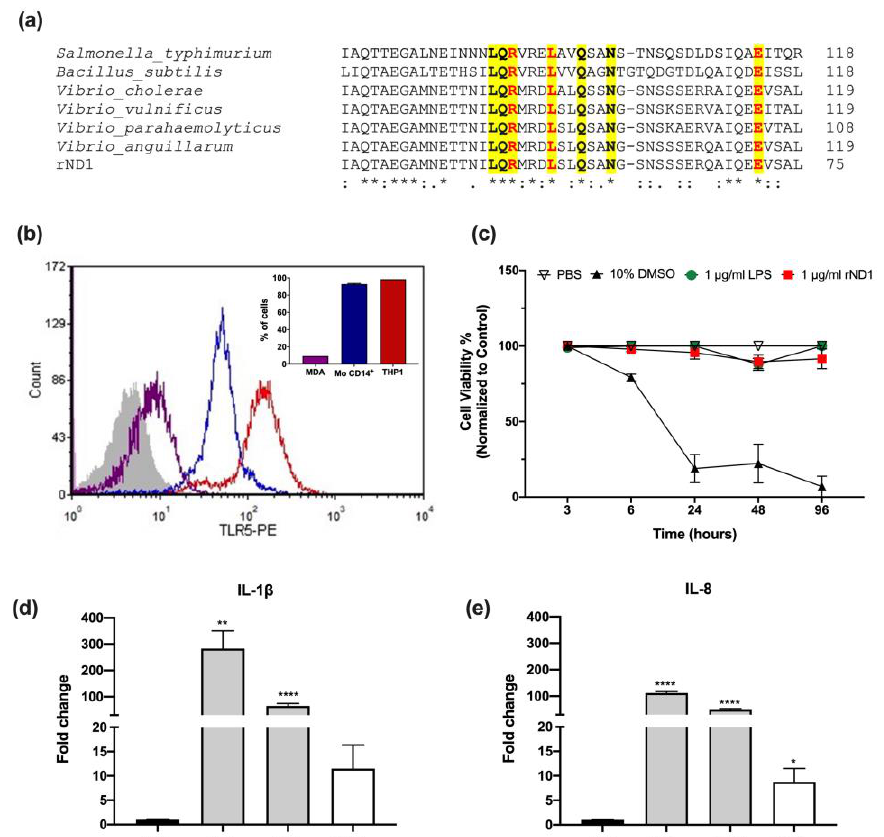
Figure 1. rND1 promotes an in vitro proinflammatory response in THP-1 cells. ( a ) Multiple alignment of the flagellin amino acid sequences from human and fish pathogens, conserved amino acid residues in rND1 are marked in bold. They key residues required for TLR5 are highlighted in yellow [5] and in red [27]; ( b ) Analysis of the expression of TLR5 by flow cytometry, histogram represents the TLR5 detection in monocytes (Mo CD14+, blue), THP-1 cells (THP1, red), MDA-MB-231 breast cancer cells (MDA, purple), and a control without primary antibody (gray). The bar graph shows the percentage of positive cells for each analyzed type; ( c ) Effect of rND1 on cell viability in THP-1 cells. The data is presented as mean ± SEM for three independent experiments and normalized to vehicle control (PBS); ( d ) IL-1 β and ( e ) IL-8 in THP-1 cell line stimulated with rND1 1 µ g/mL for 3 h. Values of fold change were calculated from the unstimulated control (CTL) after being normalized to the expression of GAPDH and β -actin. Results are presented as the mean ± SEM in triplicate. Asterisks indicate significant differences, compared to the unstimulated control and analyzed with student t-test. FLA: Flagellin from S. typhimurium (50 ng/mL); LPS: Lipopolysaccharide from E. coli K12 strain (1 μ g/mL). * p < 0.05; ** p < 0.01, *** p < 0.001, and **** p < 0.0001.